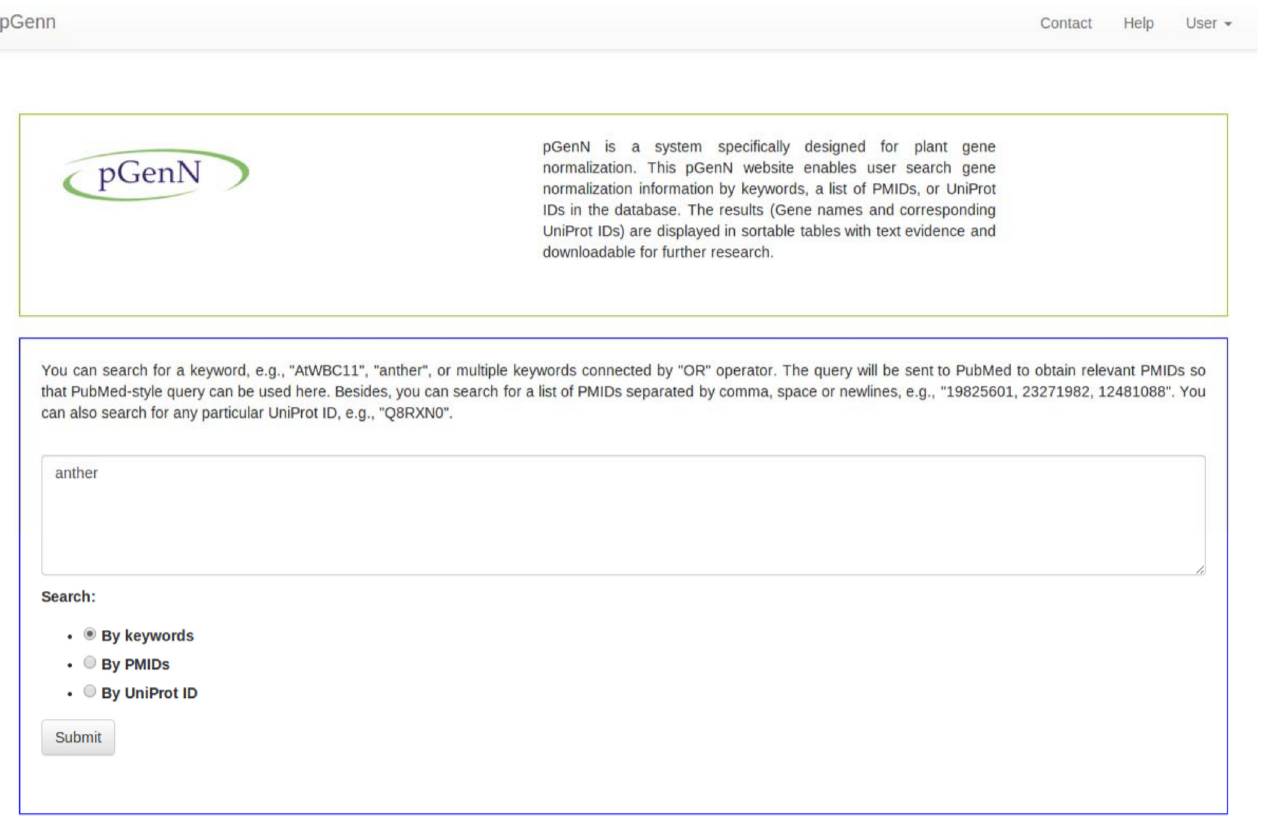
Fig 5. Screenshot of pGenN